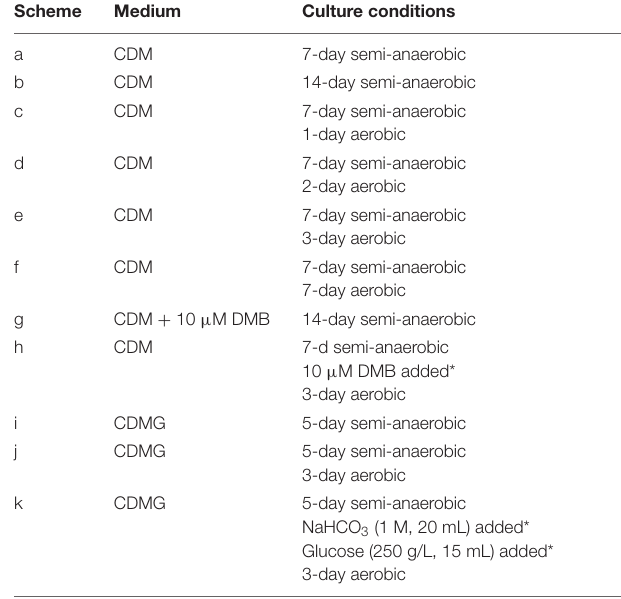
TABLE 2 | Conditions of different cultivation